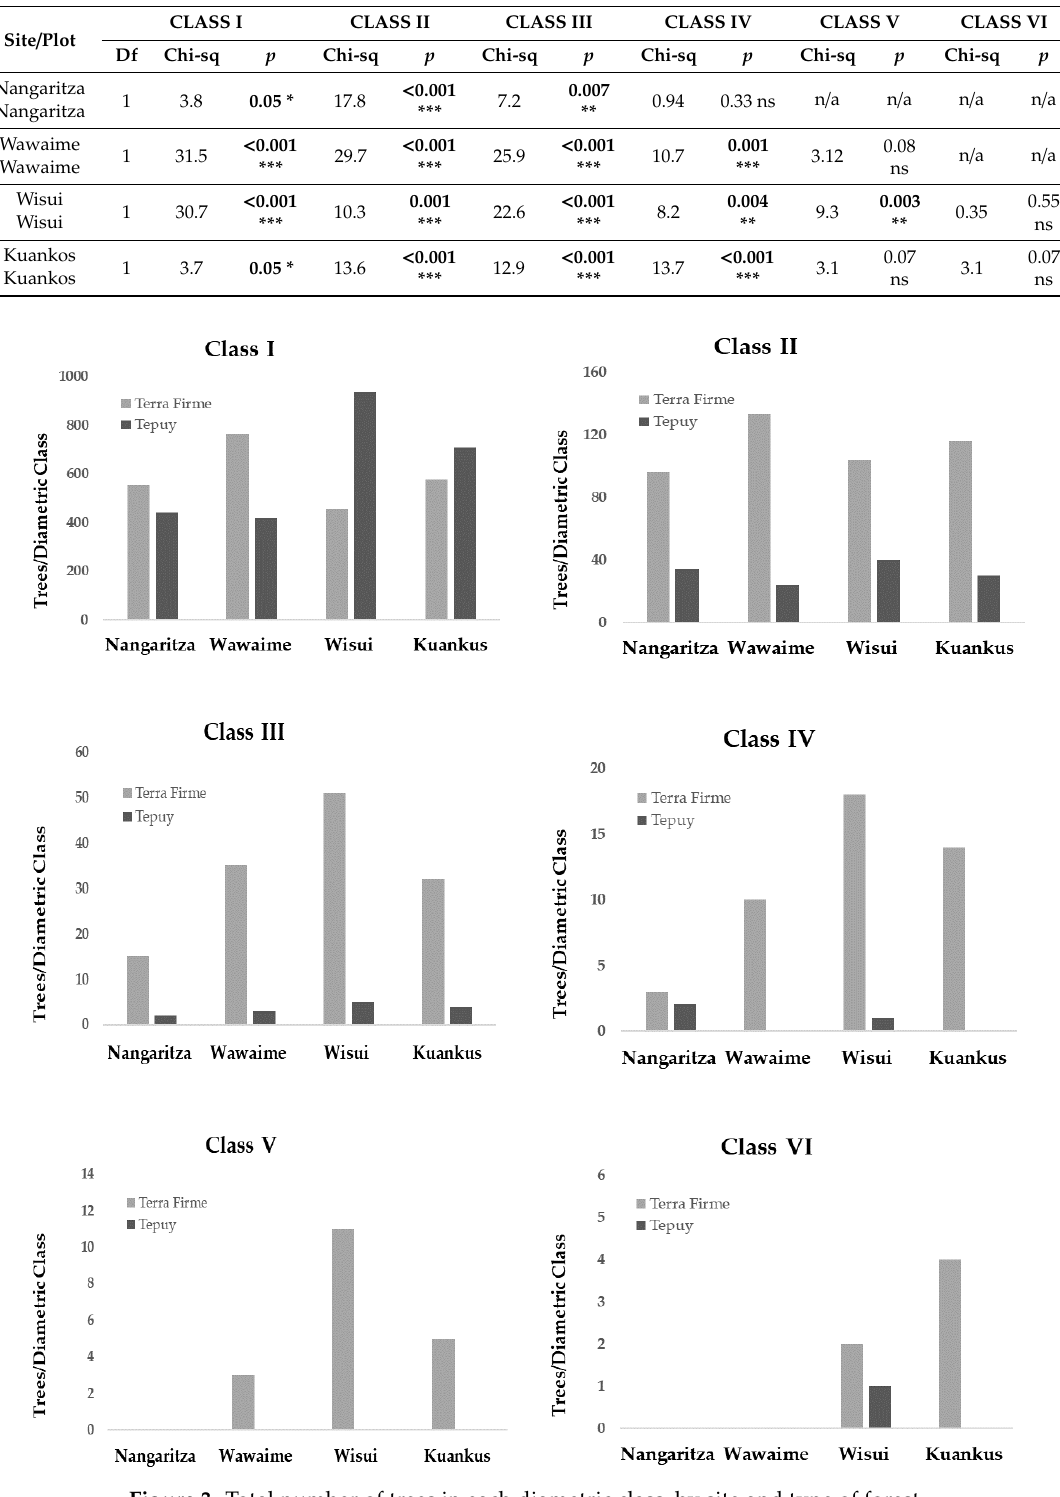
Figure 3. Total number of trees in each diametric class, by site and type of forest.